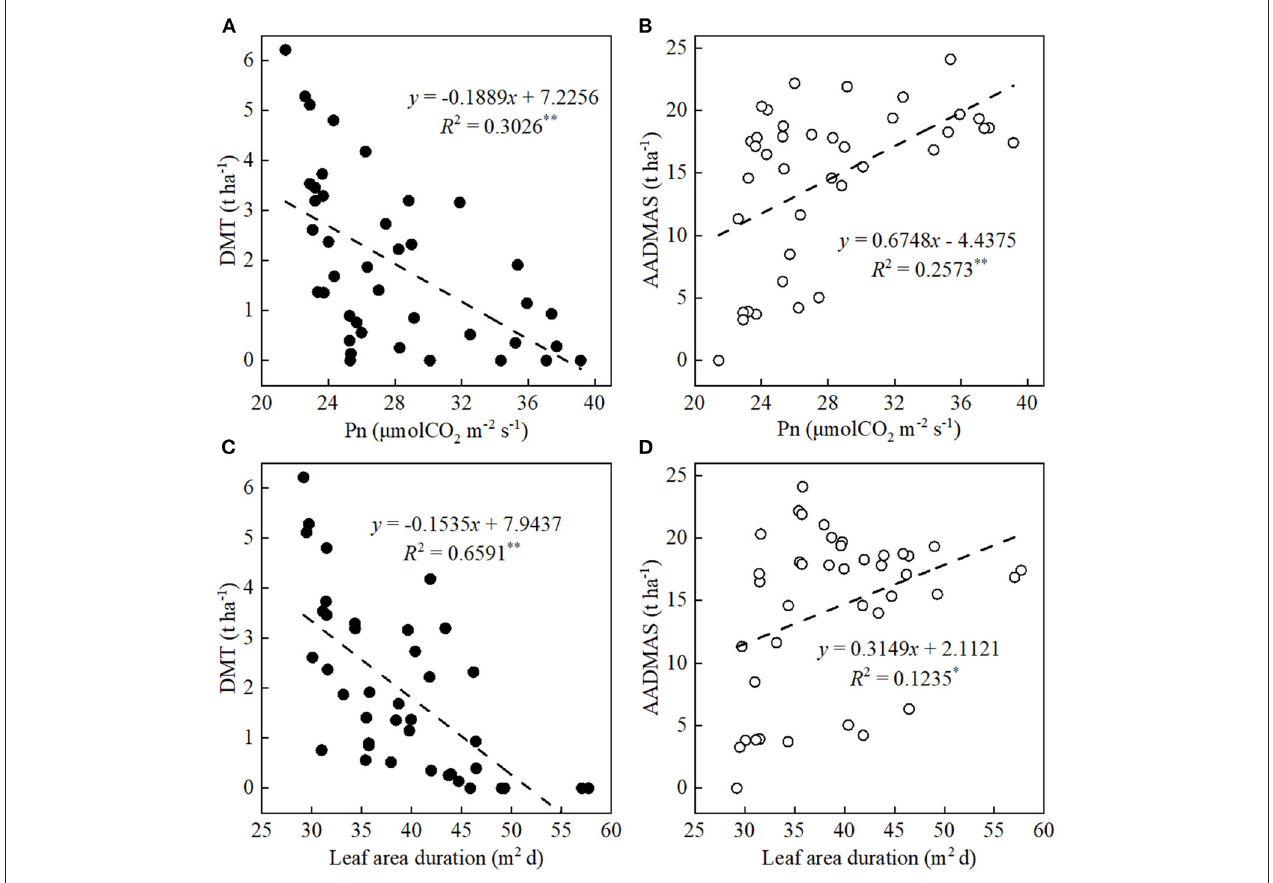
FIGURE 5 | Relationships between ear leaf photosynthetic rates ( Pn ) at the grain-filling stage and LAD with DMT and AADMAS. DMT and AADMAS are indicated by solid circles and empty circles, respectively. * P ≤ 0.05, ** P < 0.01.